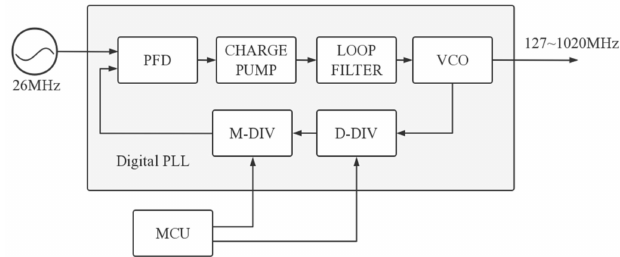
Figure 2. Block diagram of fractional-N